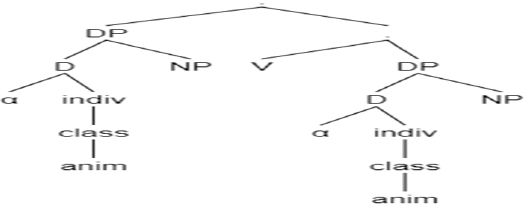
Figure 23. Before insertion of v*, inheritance, Agree, and labeling.